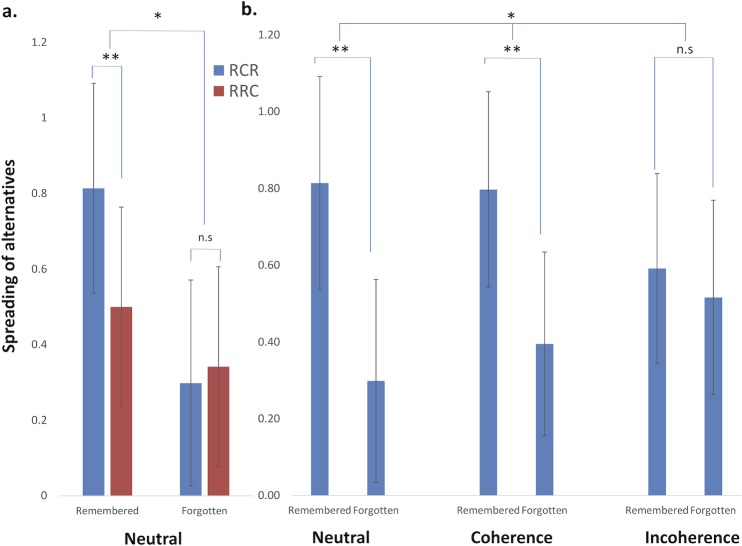
Exposure to quotes promoting self-incoherence decreased CIPC.Spreading of alternatives is computed as (second rating for a chosen item–first rating for a chosen item)–(second rating for a rejected item–first rating for a rejected item). (a) In the Neutral condition, we replicated the episodic memory dependent CIPC effect, as a significant interaction between choice-memory (Part B) and RCR/RRC condition, and confirmed that a RCR>RRC effect was present exclusively for remembered items (** for 0.001≤p<0.01; * for 0.01≤p<0.05). In all figures, error bars correspond to standard errors of the mean. (b) Comparison of spreads in the RCR condition differed across the 3 conditions: while exposure to neutral and coherence quotes showed similar CIPC effects, exposure to incoherent quotes abolished the CIPC effect.